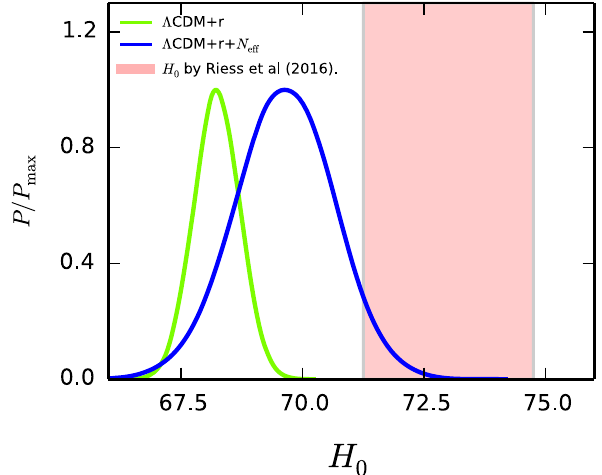
Fig. 2 The one-dimensional posterior distributions for the param- eter H 0 in the (cid:2) CDM + r and (cid:2) CDM + r + N eff models using the Planck + BK + BAO + H 0 data. The light red band denotes the new local measurement of H 0 [19]